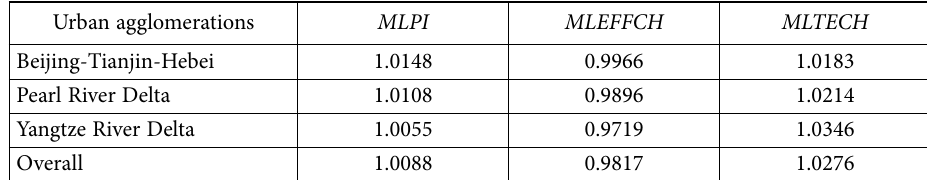
Table 4. Annual average TFP index and its decomposition of the three urban agglomerations Urban